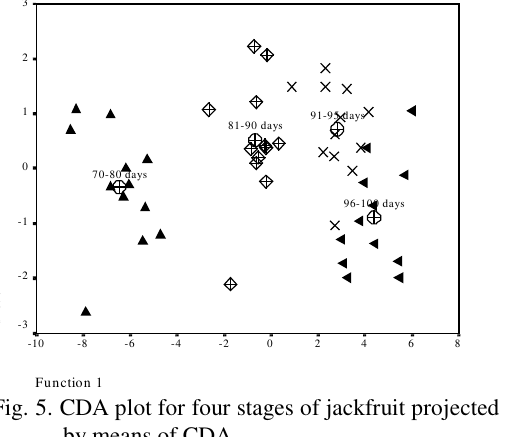
Fig. 5. CDA plot for four stages of jackfruit projected by means of CDA